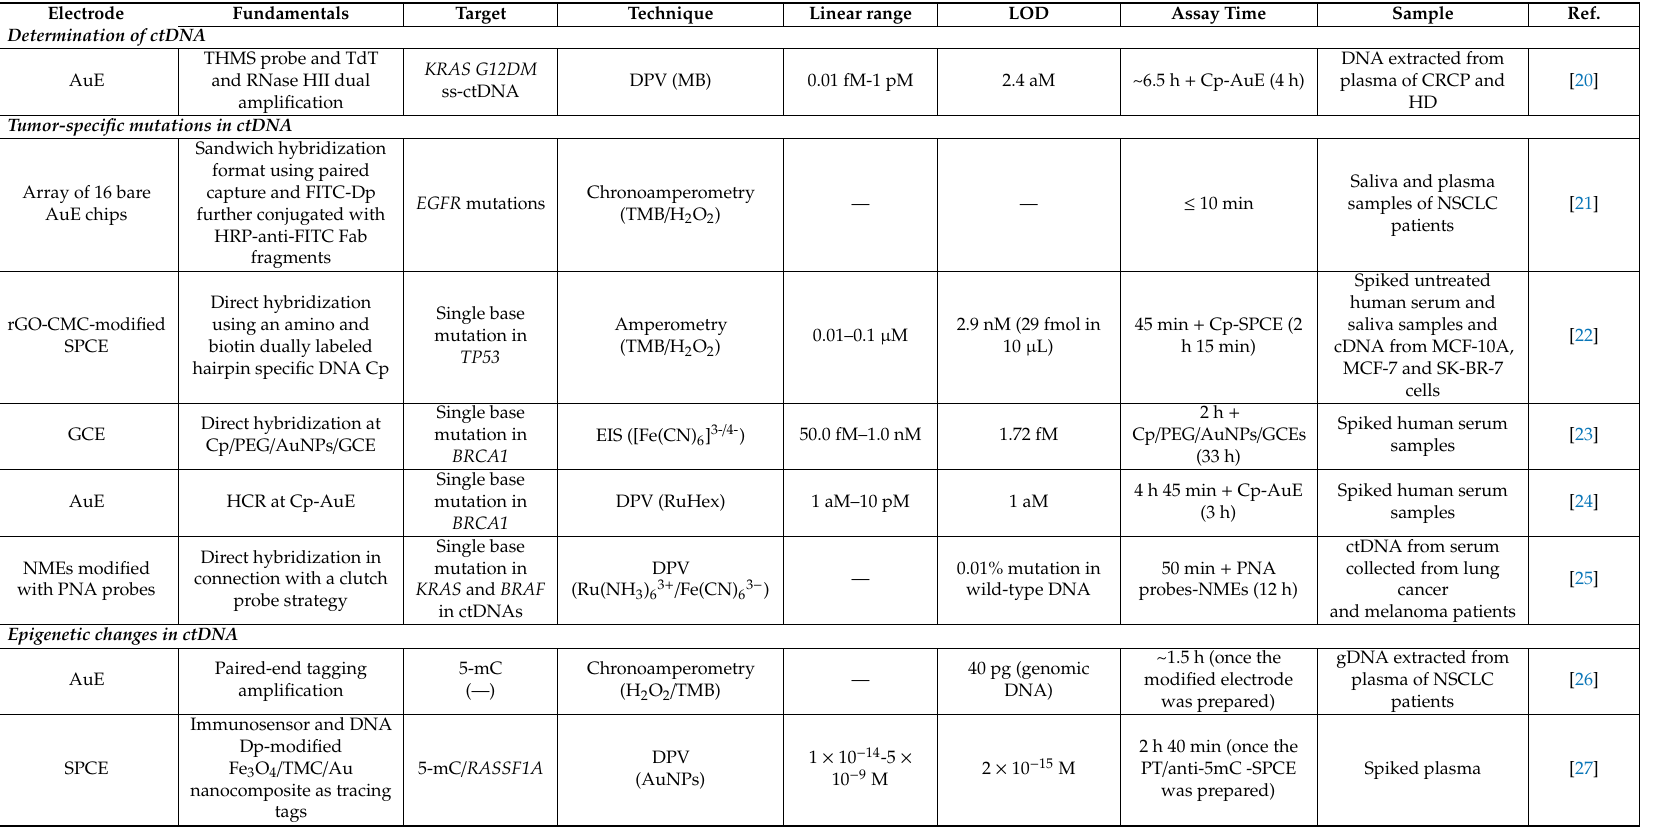
Table 1. Electrochemical biosensing strategies for determination of ctDNAs and specific